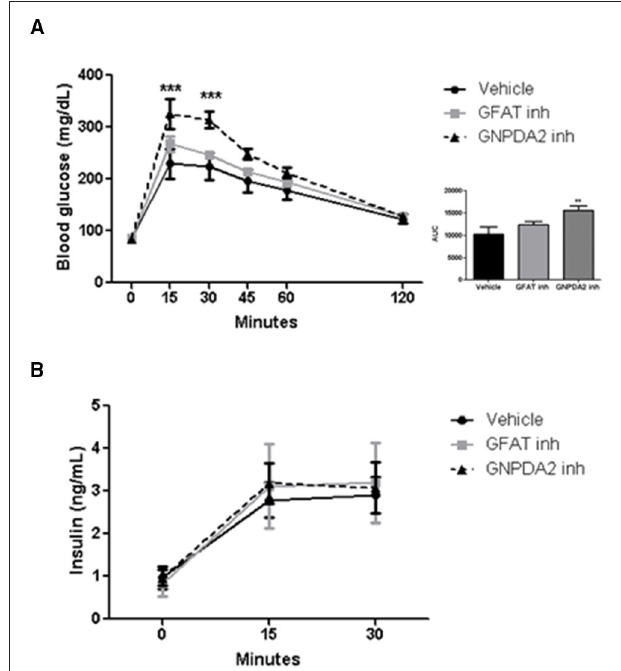
FIGURE 4 | Impact of i3vt infusion of GNPDA2 and GFAT inhibitors on glucose homeostasis. (A) Central infusion of GNPDA2 and GFAT inhibitors (150 µ g) 1h prior to the intraperitoneal glucose tolerance test. (B) Insulin levels during the GTT. Repeated measures two-way ANOVA analysis, Bonferroni posttest *** P < 0.001, ** P < 0.01. n = 8 rats per